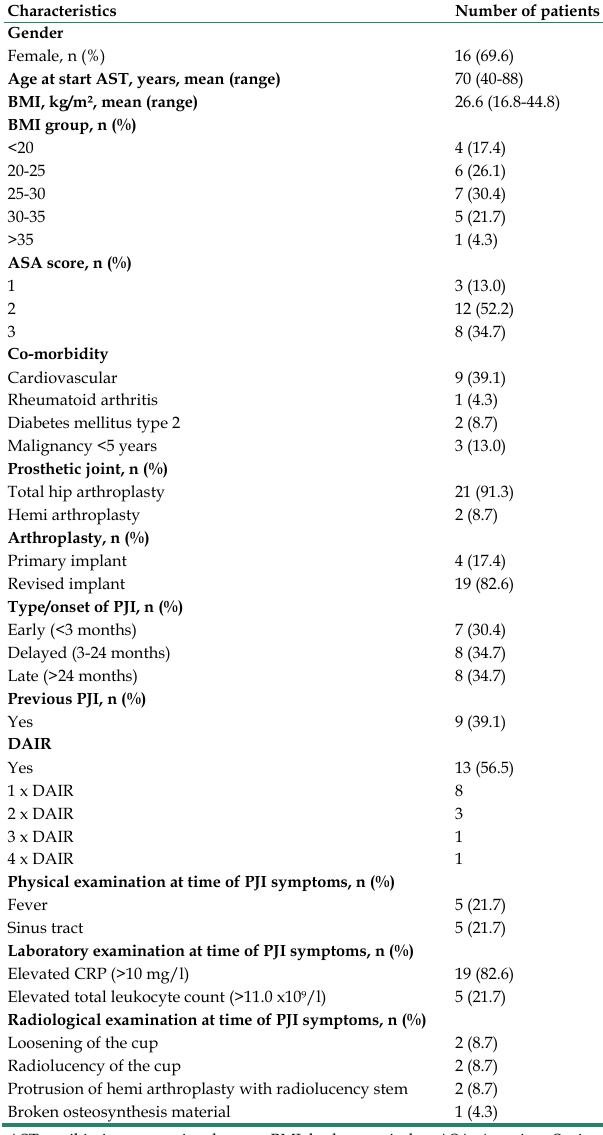
Table 1. Patient characteristics of 23 patients with PJI treated with antibiotic suppressive therapy Characteristics Number of patients